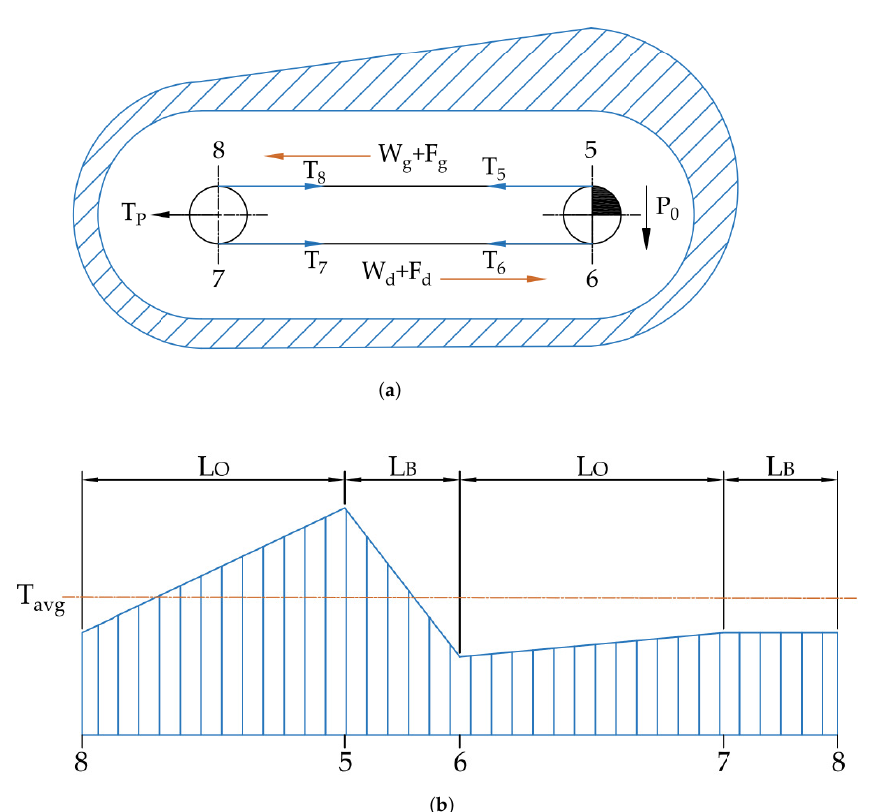
Figure 1. Distribution of belt tensile force in the intermediate drive: ( a ) real distribution, ( b ) approxi- mation adopted in the